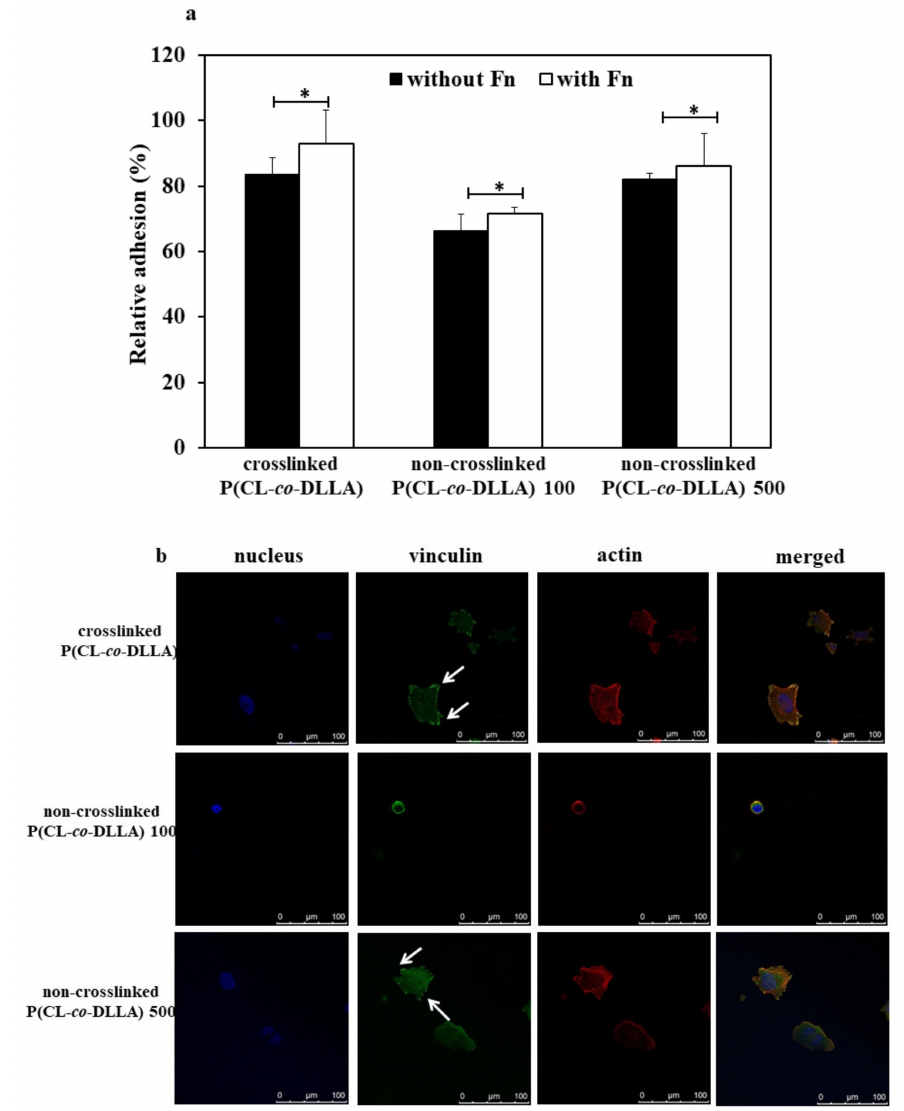
Figure 4. Adhesion behavior of MCF-7 cells on crosslinked and non-crosslinked P(CL- co -DLLA) substrates. ( a ) The substrates were coated with or without fibronectin (Fn) and the percentage of attached cells were calculated from the initial cell seeding density after 4 h. Each data represent n = 3 ± SD, where * p = 0.05 and ** p = 0.01; ( b ) Focal adhesion of MCF-7 cells on P(CL- co -DLLA) crosslinked (top images) and P(CL- co -DLLA) non-crosslinked 100 (middle images) or 500 (bottom images) substrates at 90 min. The white arrows indicated the focal adhesion protein